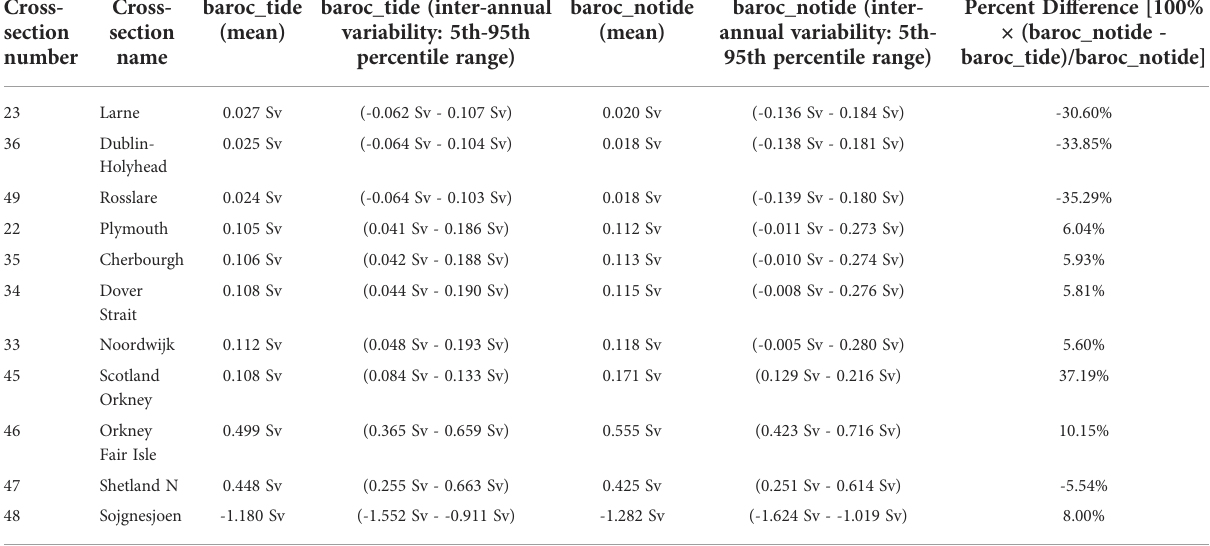
TABLE 2 Mean transport through cross-sections for baroc_tide and baroc_notide. Cross-